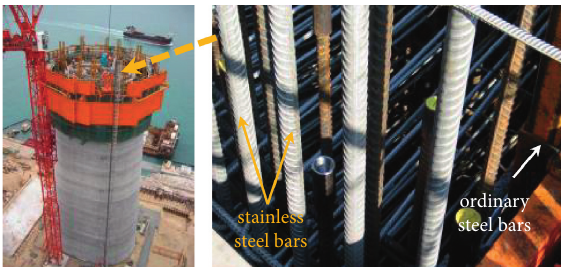
Figure 8: The mixed reinforcement grid of the Stonecutters Bridge in Hong